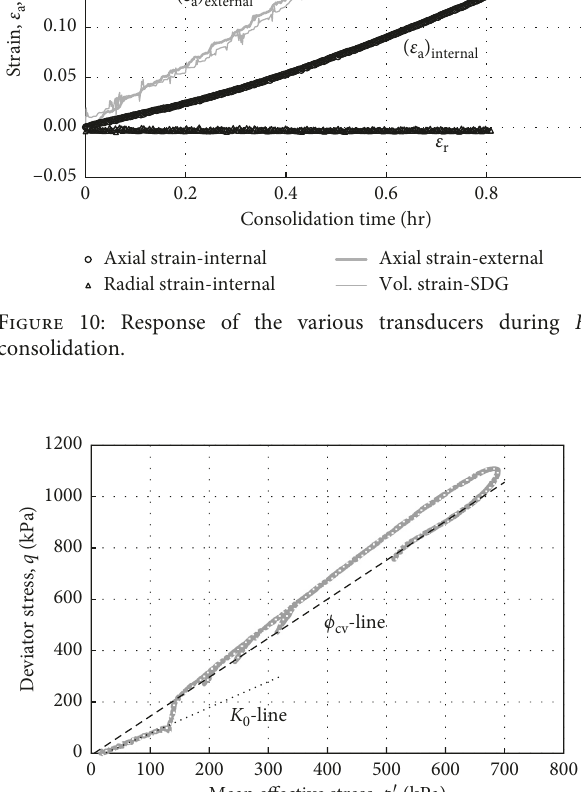
0 -line and f cv -line.